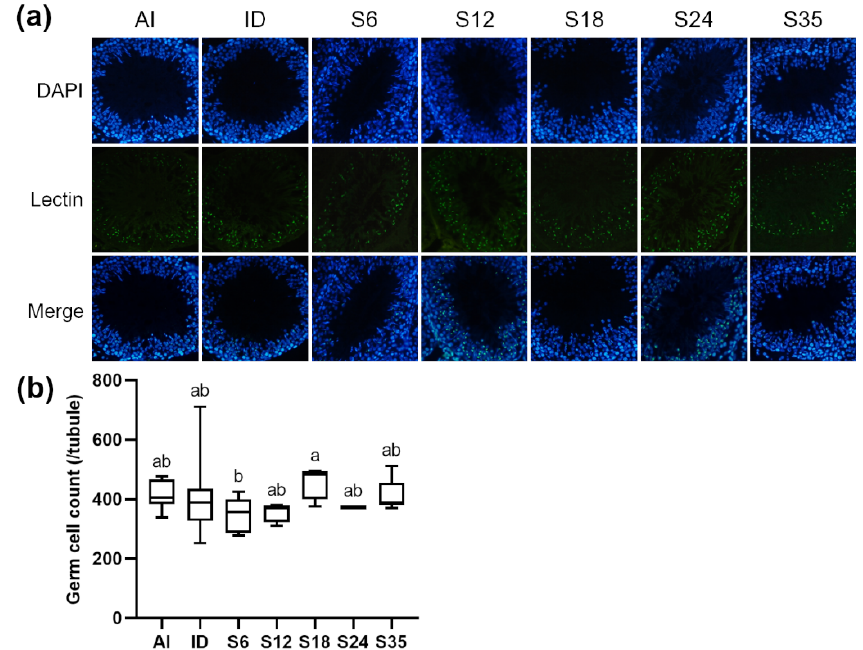
Figure 8. Effects of different doses of iron supplementation on ( a ) testicular seminiferous tubules by DAPI (nucleus) and Lectin (acrosome) staining, and ( b ) germ cell numbers in stage VI of spermatogenesis in iron-deficient rats. Values are presented as median (interquartile range, IQR). n = 4 per group. Values not sharing the same letters are significantly different at p < 0.05.